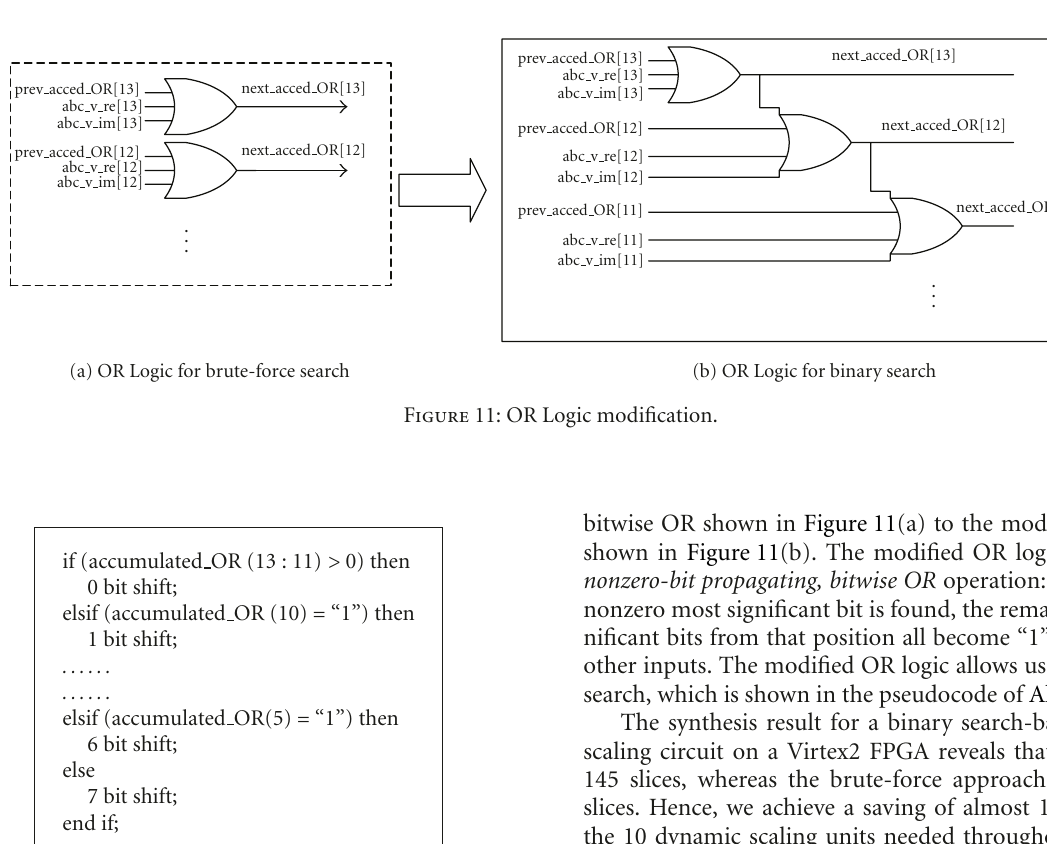
Figure 10: Dynamic scaling circuit.